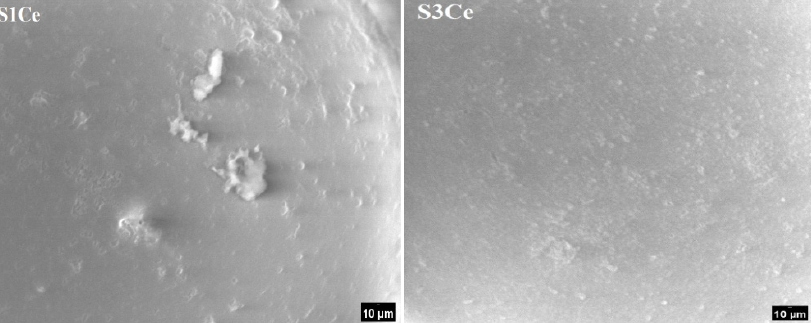
Figure 9. SEM micrographs of the S1Ce and S3Ce composite scaffolds after immersion for five days in SBF solution.